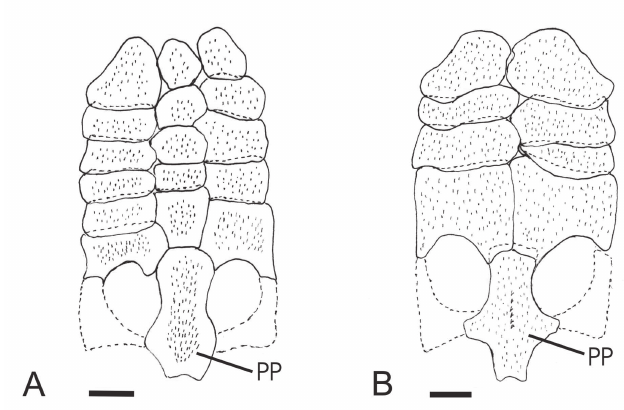
Fig. 4 . Abdominal and preanal plates. A. Acestridium triplax ; B. Acestridium dichromum . PP: preanal plate. Scale: 1